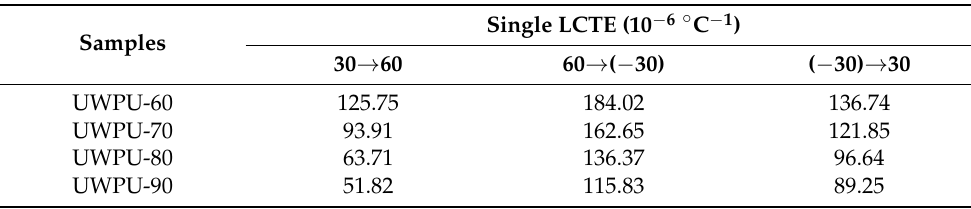
Table 2. Linear coefficient of thermal expansion (LCTE) of the UWPU composites measured in the